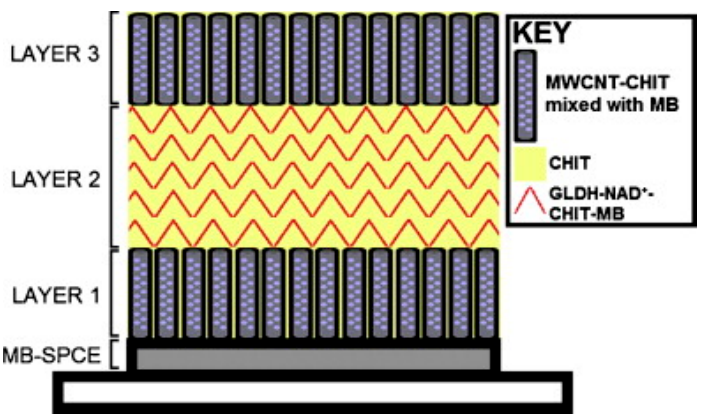
Figure 3. A schematic diagram displaying the layer-by-layer drop coating fabrication procedure used to construct the reagentless glutamate biosensor, based on a MB-SPCE electrode. Reproduced with permission from [24].